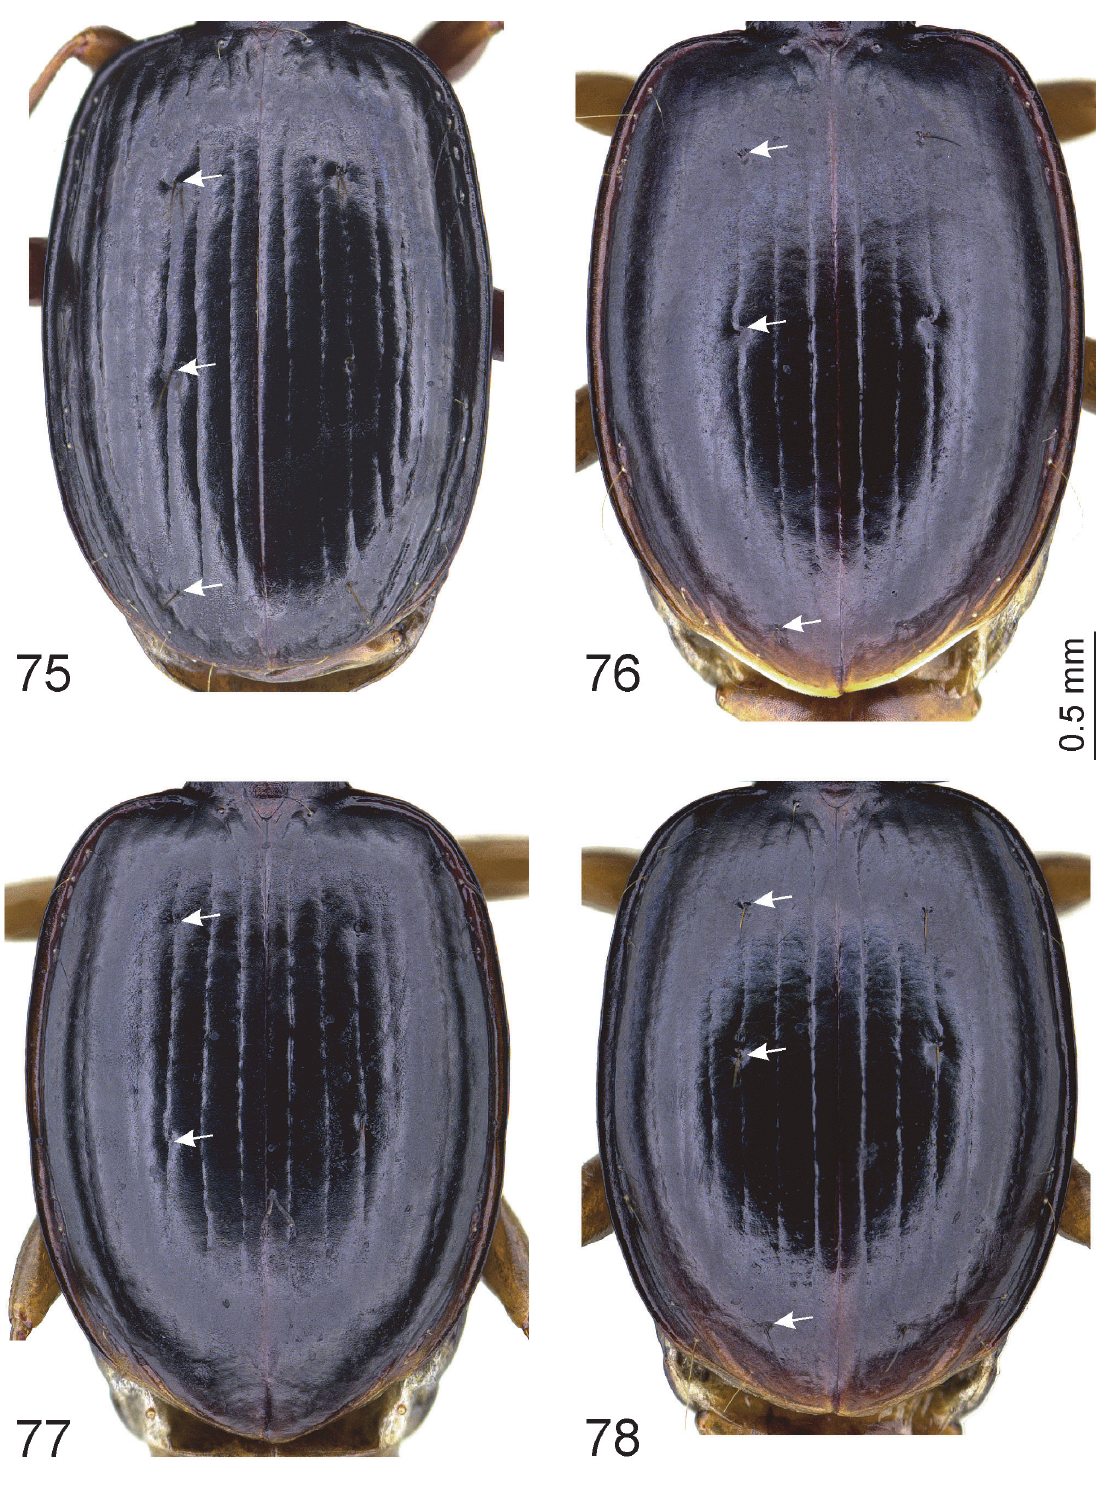
Figs 75–78. Trechus spp., elytra. 75 . T. depressipennis sp. nov., holotype. 76 . T. mekbibi sp. nov., paratype, ♂. 77 . T. hagenia sp. nov., paratype, ♂. 78 . T. colobus sp. nov., paratype, ♂. The arrows point to the insertions of the discal setae and the preapical seta (if